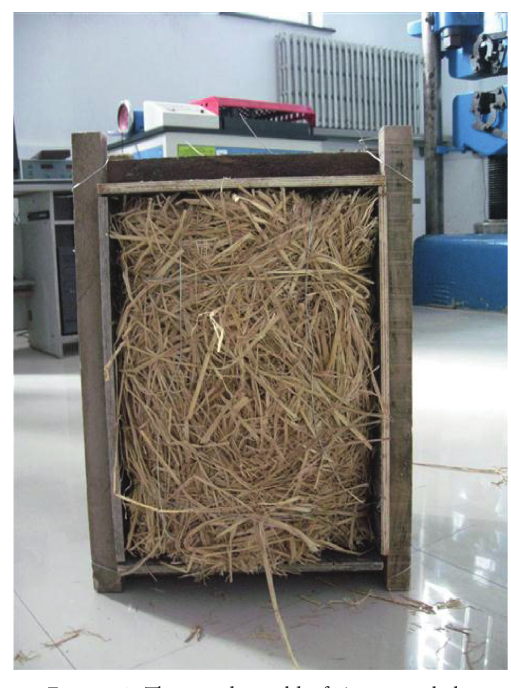
Figure 1: The wood mould of rice straw